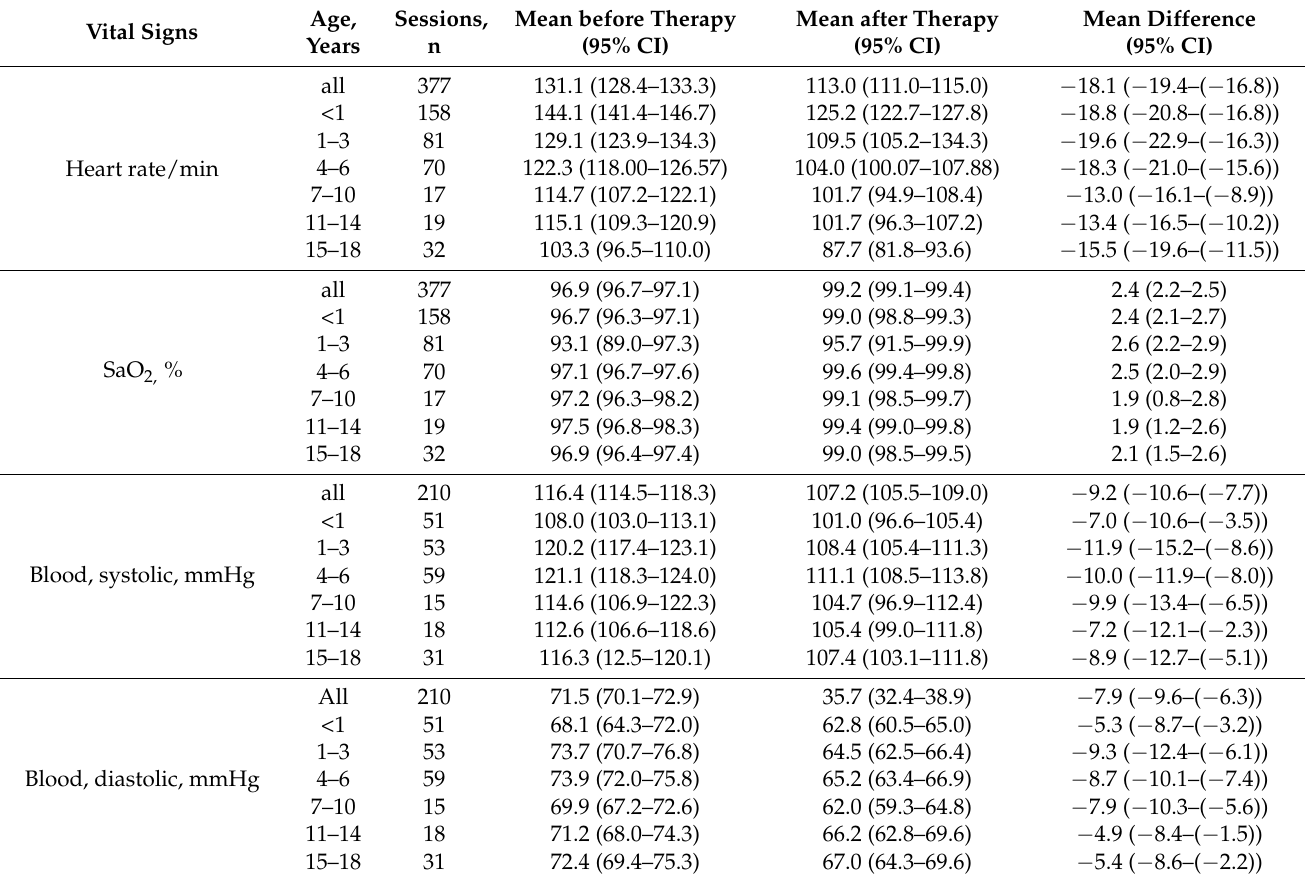
Table 2. Heart rate, oxygen saturation and blood pressure before and after music therapy